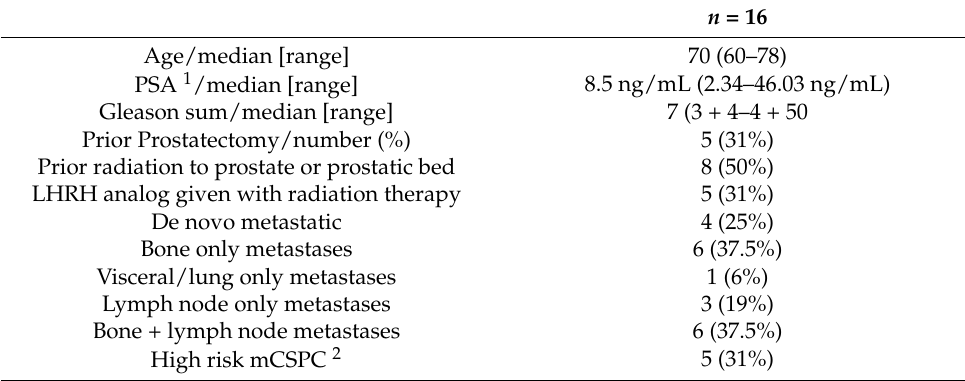
Table 1. Patient